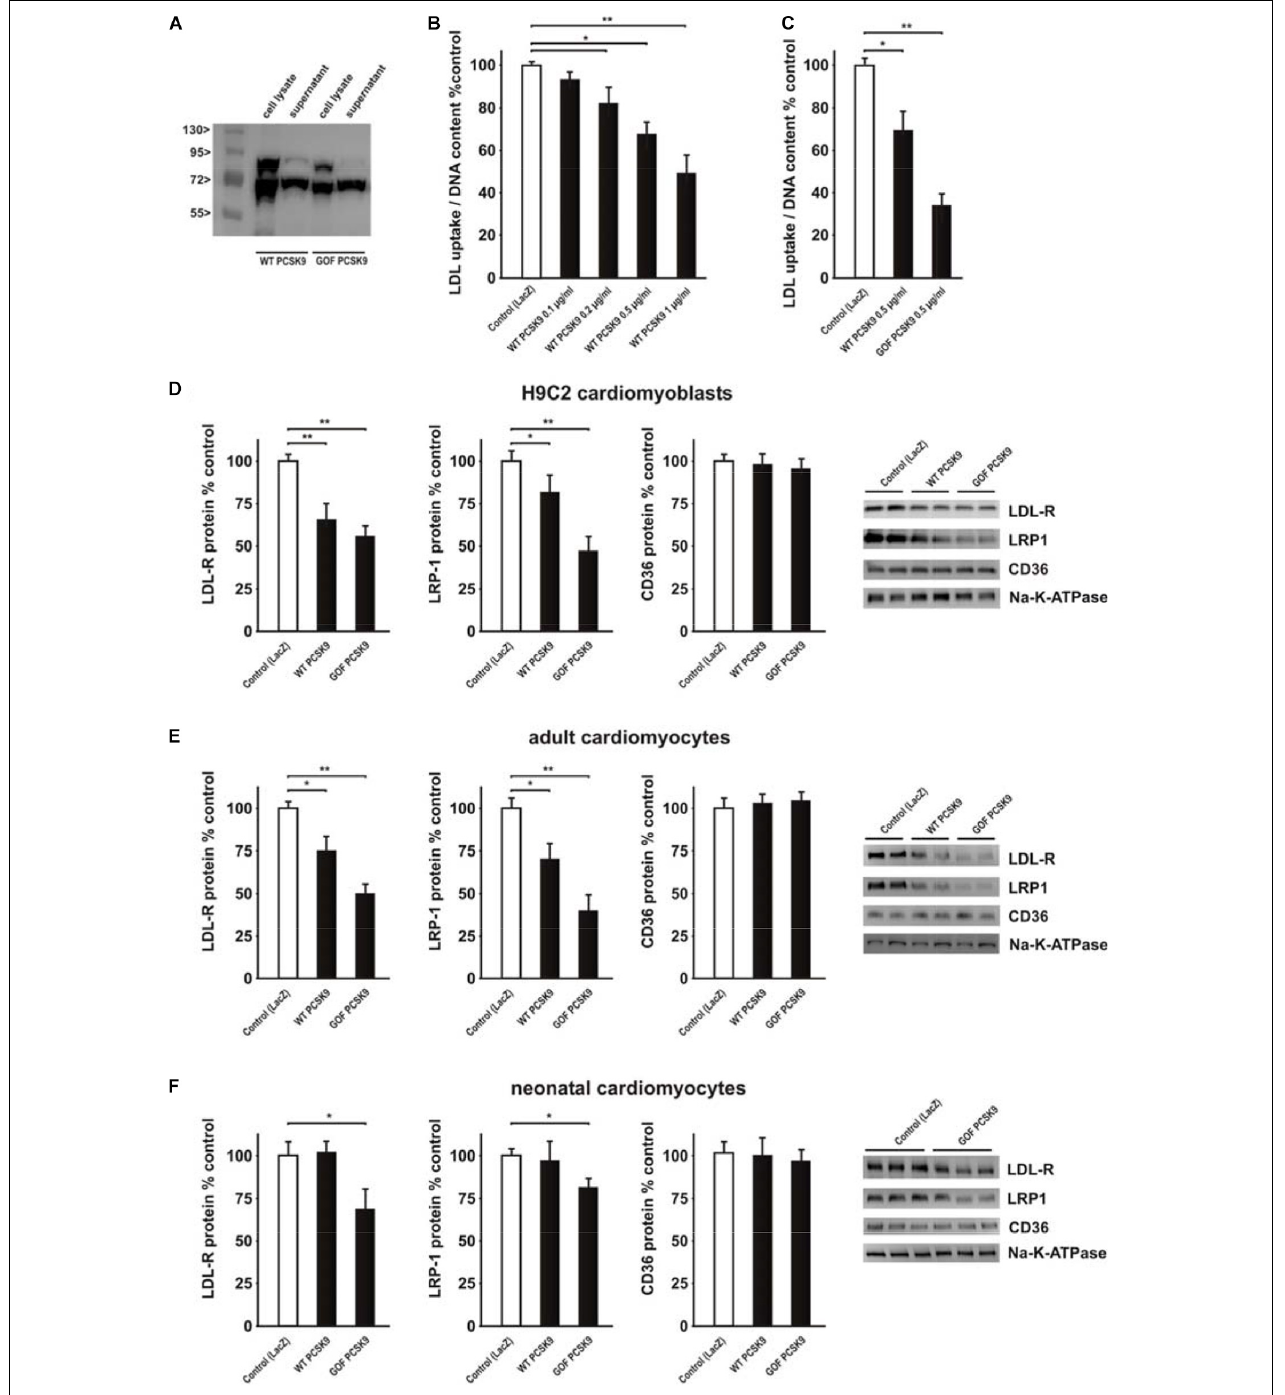
FIGURE 4 | Impact of exogenous PCSK9 on LDL uptake and LDL-R or LRP1 protein expression. (A) HepG2 cells were treated with an adenovirus expressing murine wild-type PCSK9 or a gain-of-function (GOF) variant of PCSK9 (D377Y). Cell lysates and supernatants of HepG2 cells were collected 48 h after infection and analyzed by Western Blotting. (B) H9C2 cells were treated with murine wild-type PCSK9 at the indicated concentration for 24 h and LDL uptake normalized per DNA content as a measure of cell number was analyzed afterward. (C) H9C2 cells were treated with murine wild-type PCSK9 or GOF PCSK9 (each 0.5 µ g/ml) for 24 h and LDL uptake was analyzed afterward. (D) H9C2 cells were treated with murine wild-type PCSK9 or GOF PCSK9 (each 0.5 µ g/ml) for 24 h and afterward the membrane and cytosolic fraction were isolated from these cells. Representative Western blots for LDL-R, LRP1 or CD36 and densitometry of the according protein data are shown. Na-K-ATPase served as a loading control. (E) Adult rat cardiomyocytes were treated and analyzed as described in (D) . (F) Neonatal rat cardiomyocytes were treated and analyzed as described in (D) . All data are mean ± SEM, 4 independent experiments, n = 8–24 per group, * p < 0.05, ** p < 0.01.